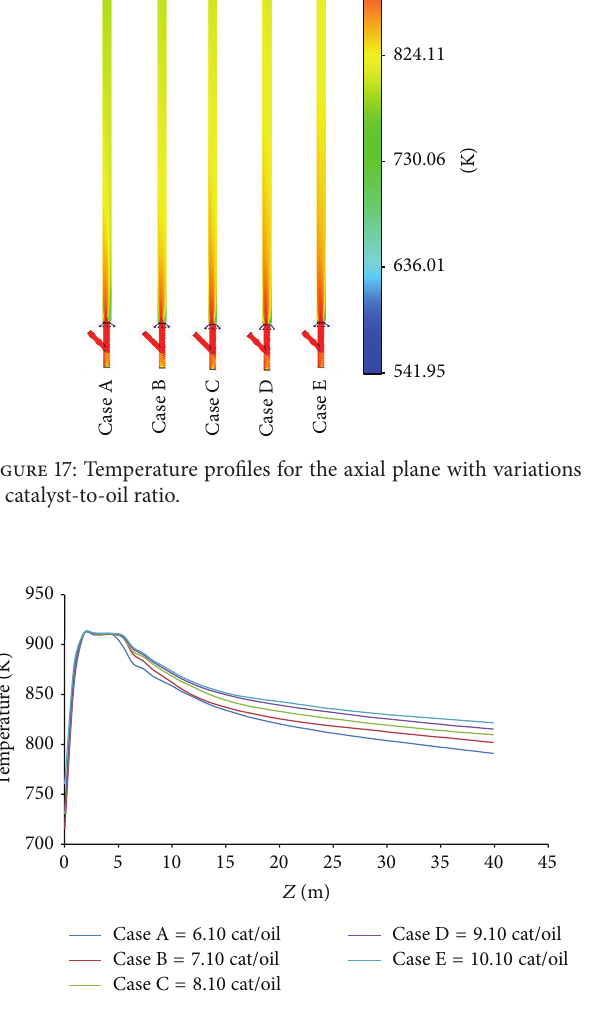
Figure 18: Temperature profiles for the riser with variation in catalyst-to-oil ratio.